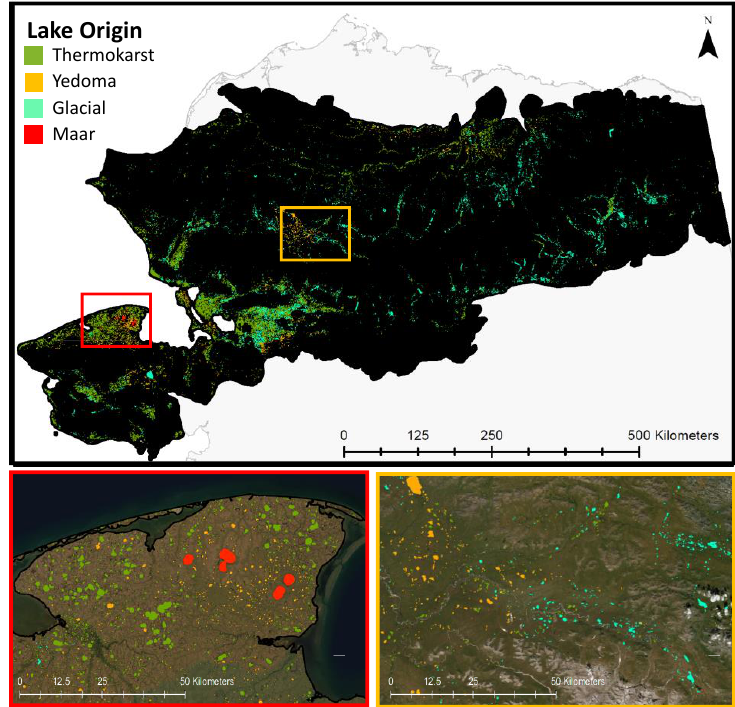
Figure 5. The probability of thermokarst and non-thermokarst lakes using the Thermokarst lake Settlement Index (TSI). Violin plots display the differing distribution of TSI values for 3335 thermokarst and 1854 non-thermokarst lakes, where the median TSIs were 0.467 and 2.657, respectively ( A ). Logistic regression identified a TSI of 1.27 as the 50% probability threshold to classify thermokarst and non-thermokarst lakes ( B ).